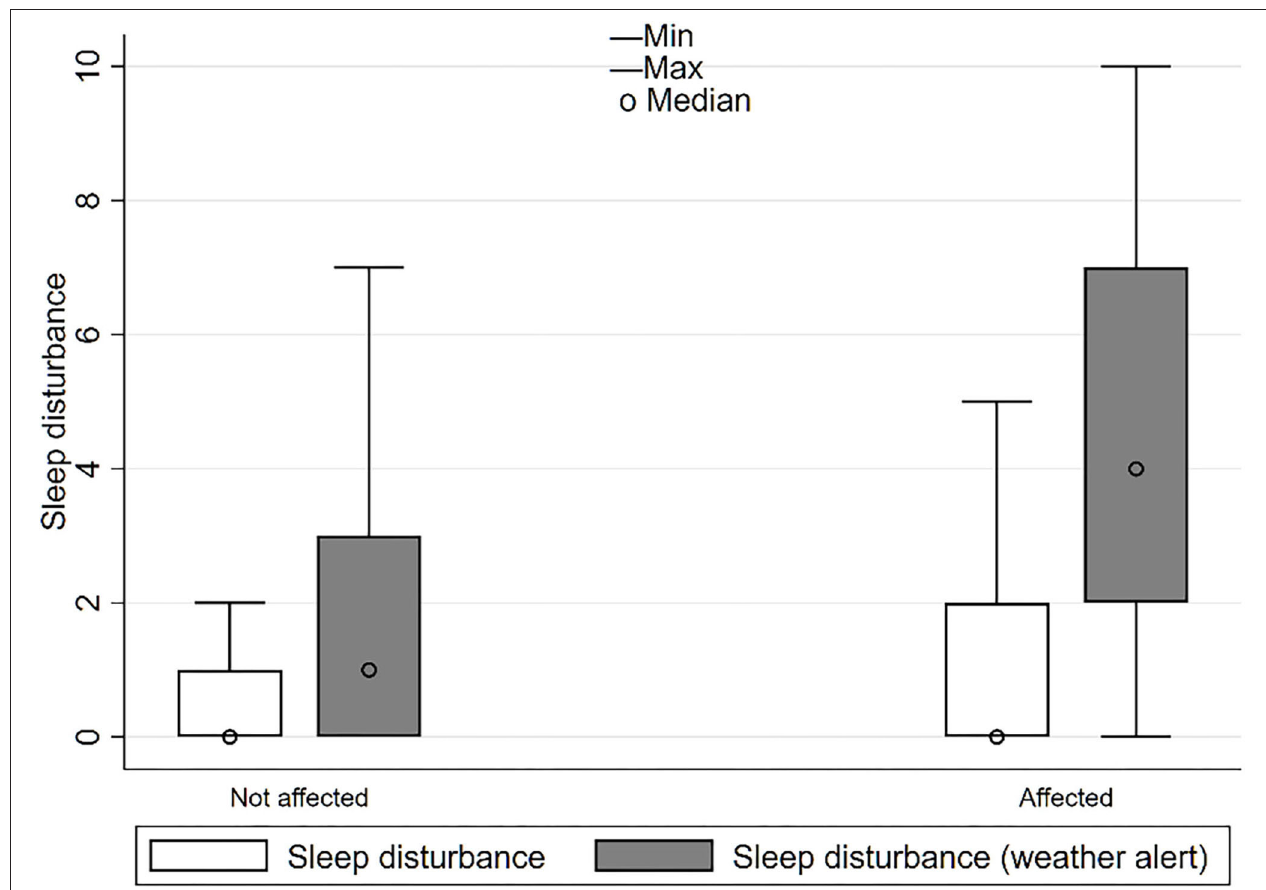
FIGURE 3 | Respondents’ level of sleep disturbance according to their condition.